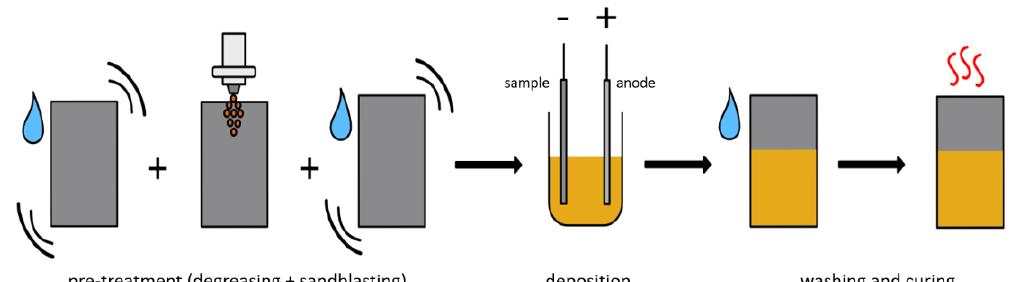
Figure 1. Scheme of the sample production process.